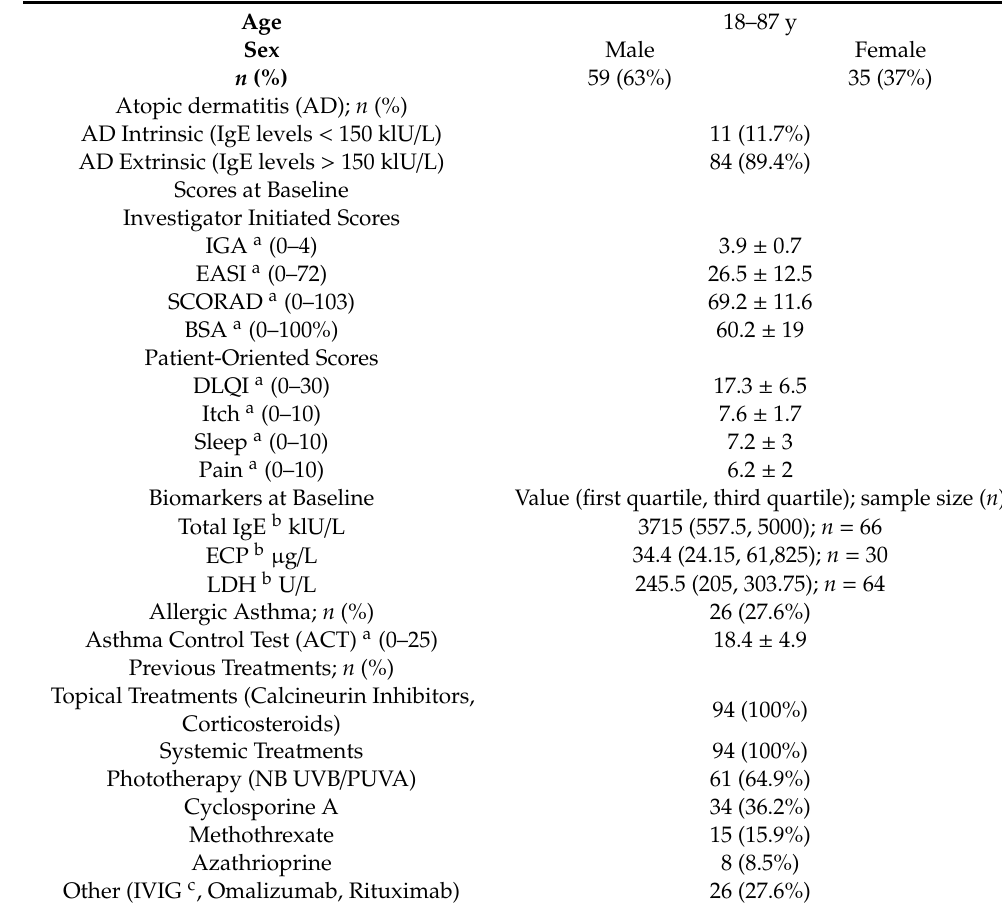
Table 1. Baseline characteristics ( n =